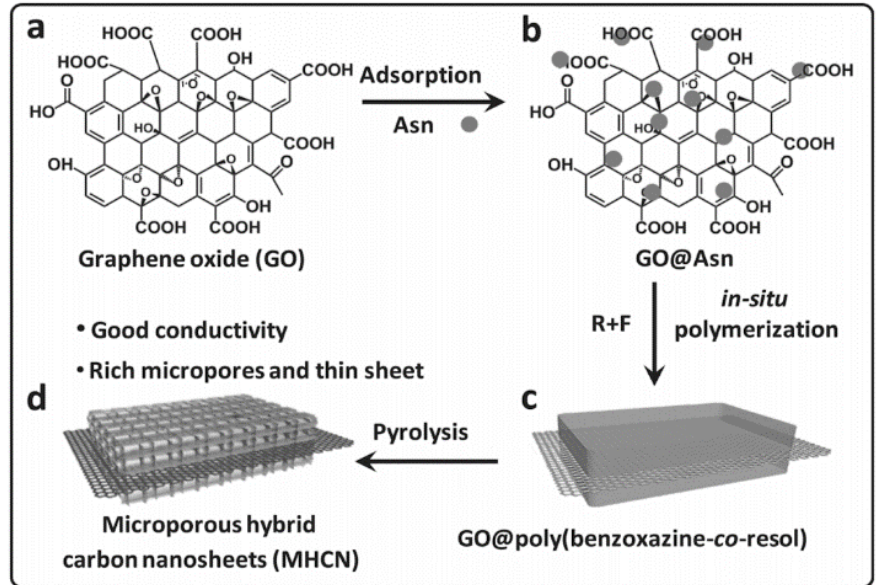
Figure 34. Synthesis principle of MHCN ( a ) negatively charged GO colloids; ( b ) the selected amino acid, asparagine (Asn) dispersed on GO platforms; ( c ) in situ reaction and condensation of pre-loading Asn, resorcinol and formaldehyde, forming poly(benzoxazine-co-resol) layer; and ( d ) formation of microporous hybrid carbon nanosheets during pyrolysis (reproduced from the work in [91] with permission).